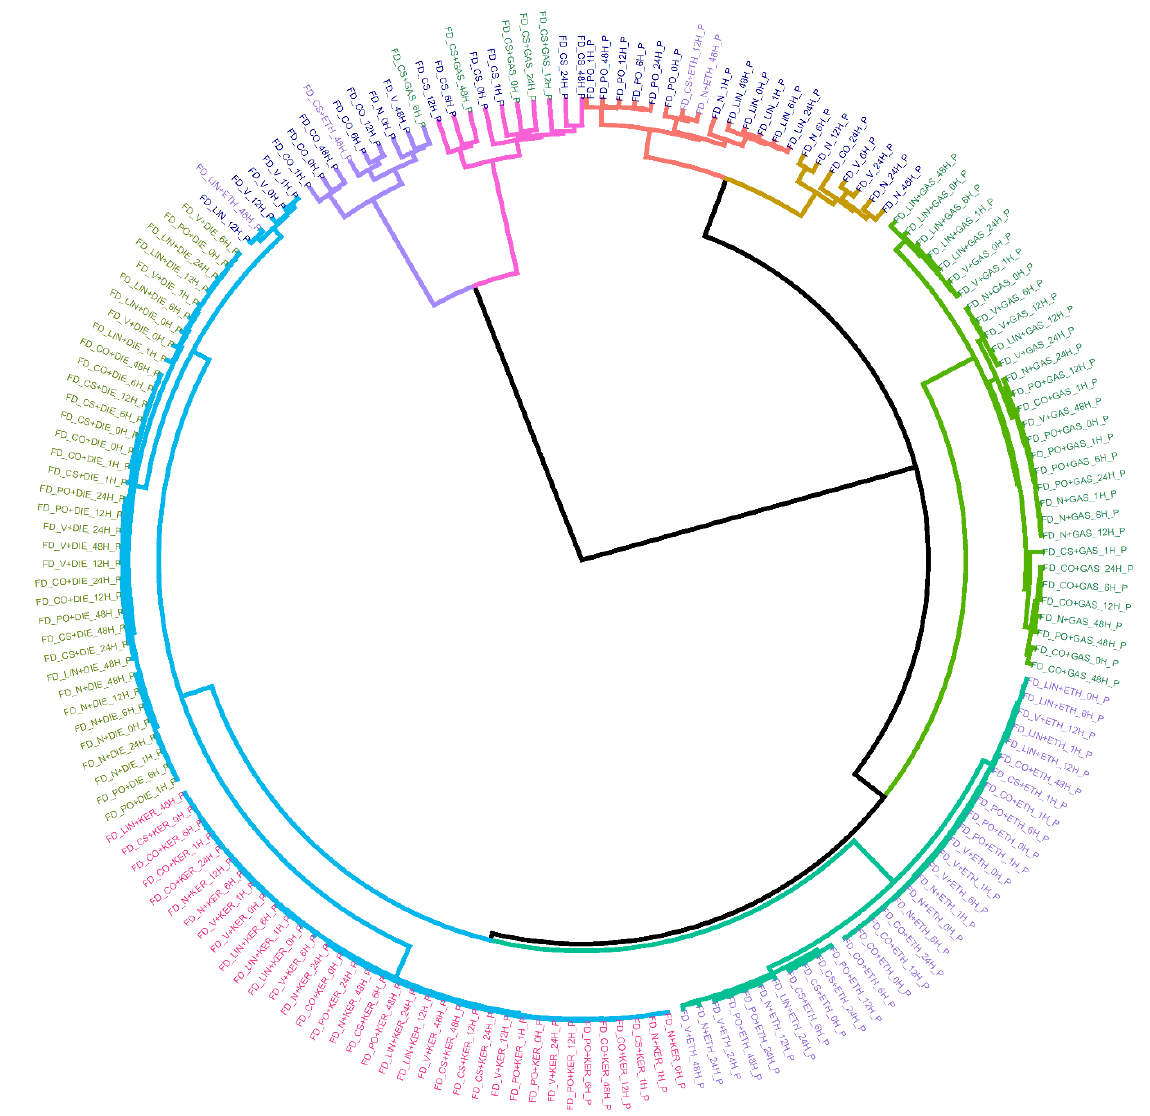
Figure 1. Dendrogram resulting from the hierarchical cluster analysis (HCA) analysis using average values of the replicas. Ward´s method with Manhattan distances were used. Samples are colored according to the type of IL use for burning: DIE (light green), GAS (dark green), KER (pink), and ETH (purple) and substrate burned without IL (dark blue).